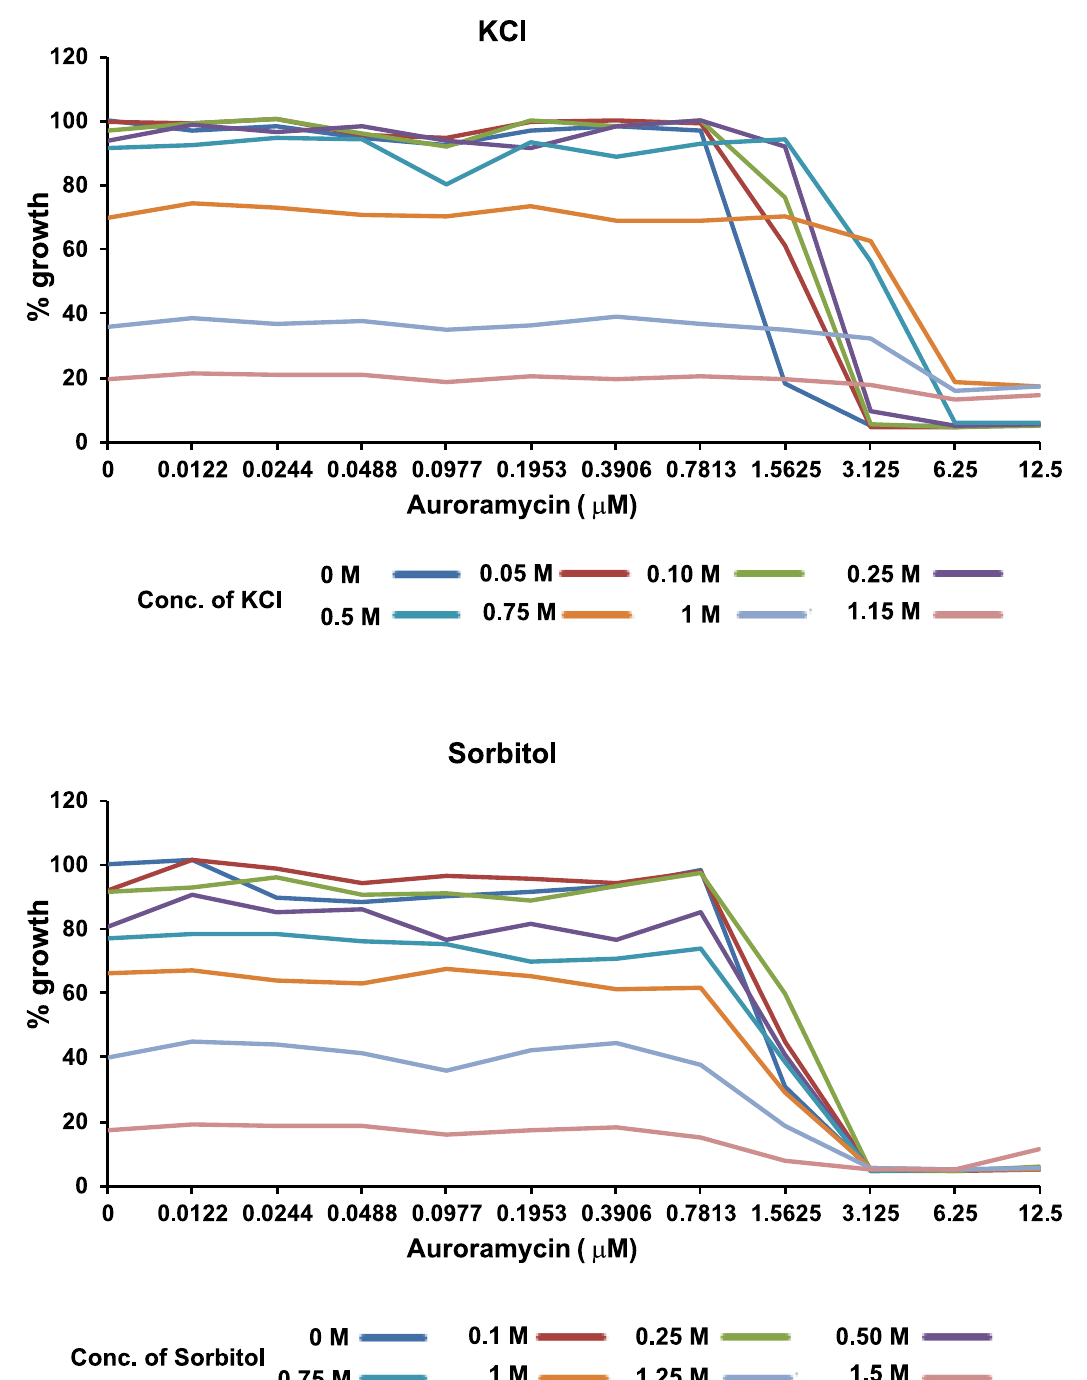
Fig 9. KCl but not sorbitol suppresses the inhibitory effect of auroramycin. Wild type yeast strain (BY4743) was grown in YPD medium containing different concentrations of auroramycin and either KCl or sorbitol at the indicated concentrations in duplicate in a 96-well plate. Average growth of the duplicate cultures at the different concentrations after 16 hours of incubation at 30 ˚C is plotted. Plots indicating the duplicate OD 600 nm values with a picture of the corresponding plate are presented in S5 Fig. Representative data from two independent experiments are